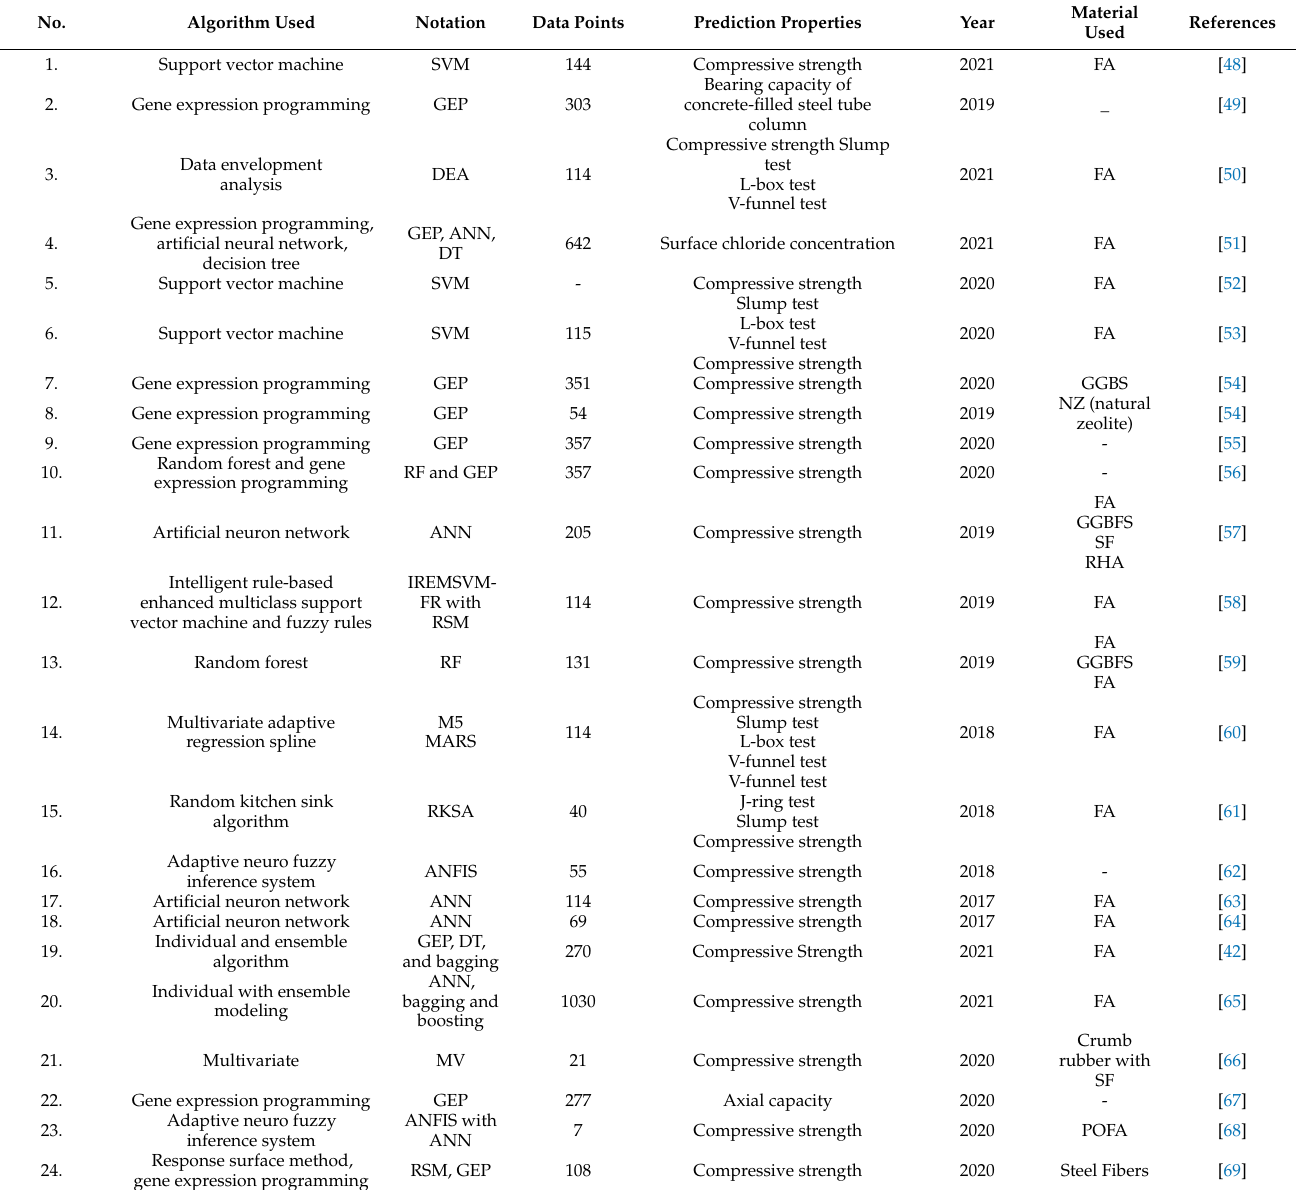
Table 1. Prediction properties using different